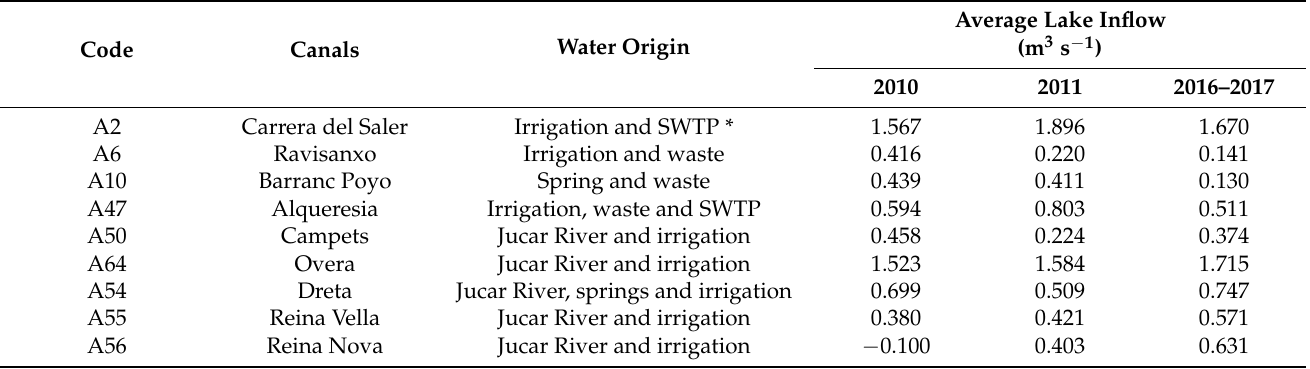
Table 1. Average lake inflows and water origin for the main canals of the Natural Park of Albufera, measured in 2010, 2011 and 2016–2017.